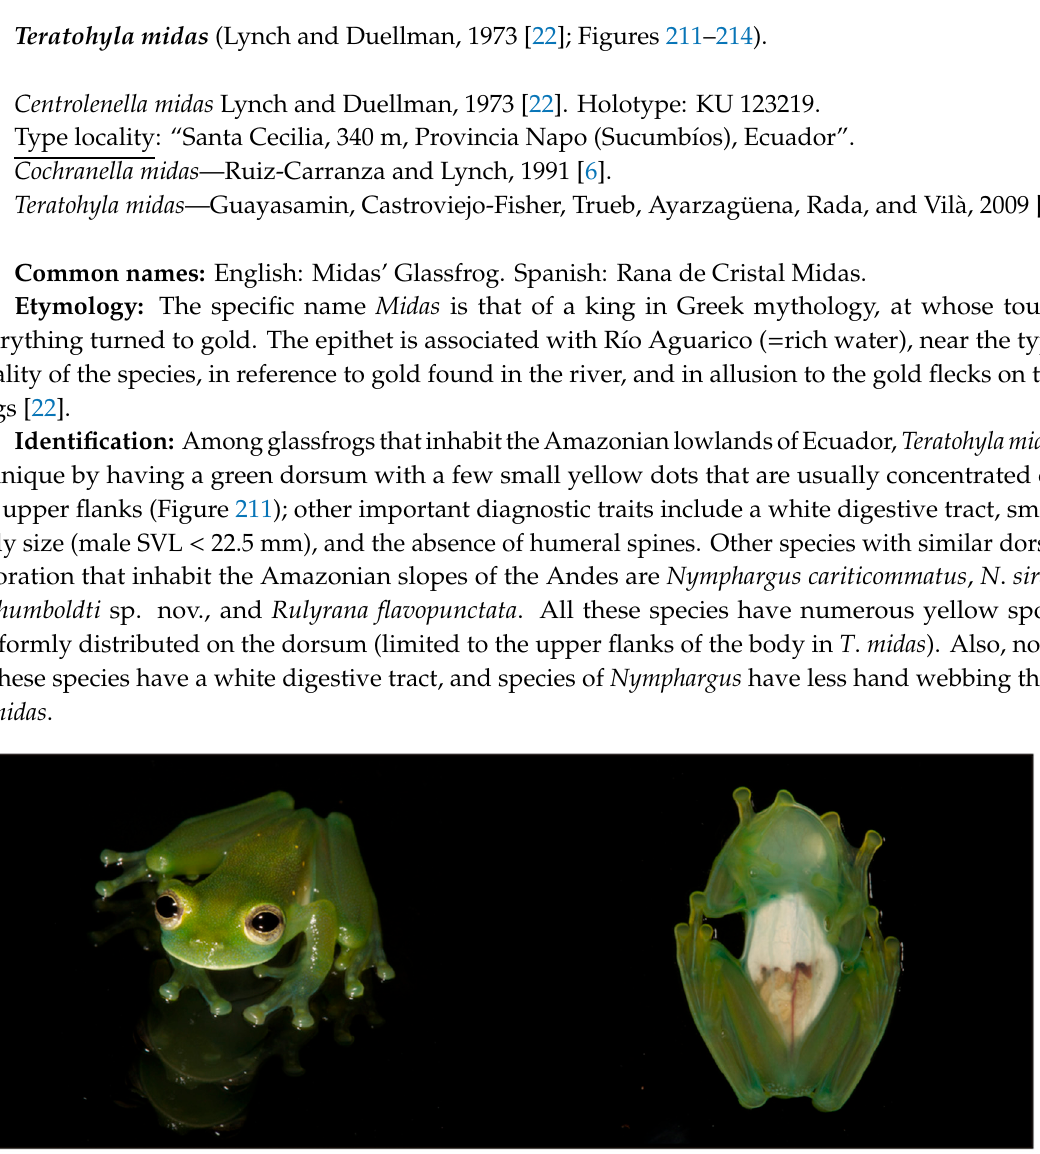
Figure 211. Teratohyla midas in life. Adult male from stream near Tena, 708 m, MZUTI 1621. Photos by Eduardo Toral.